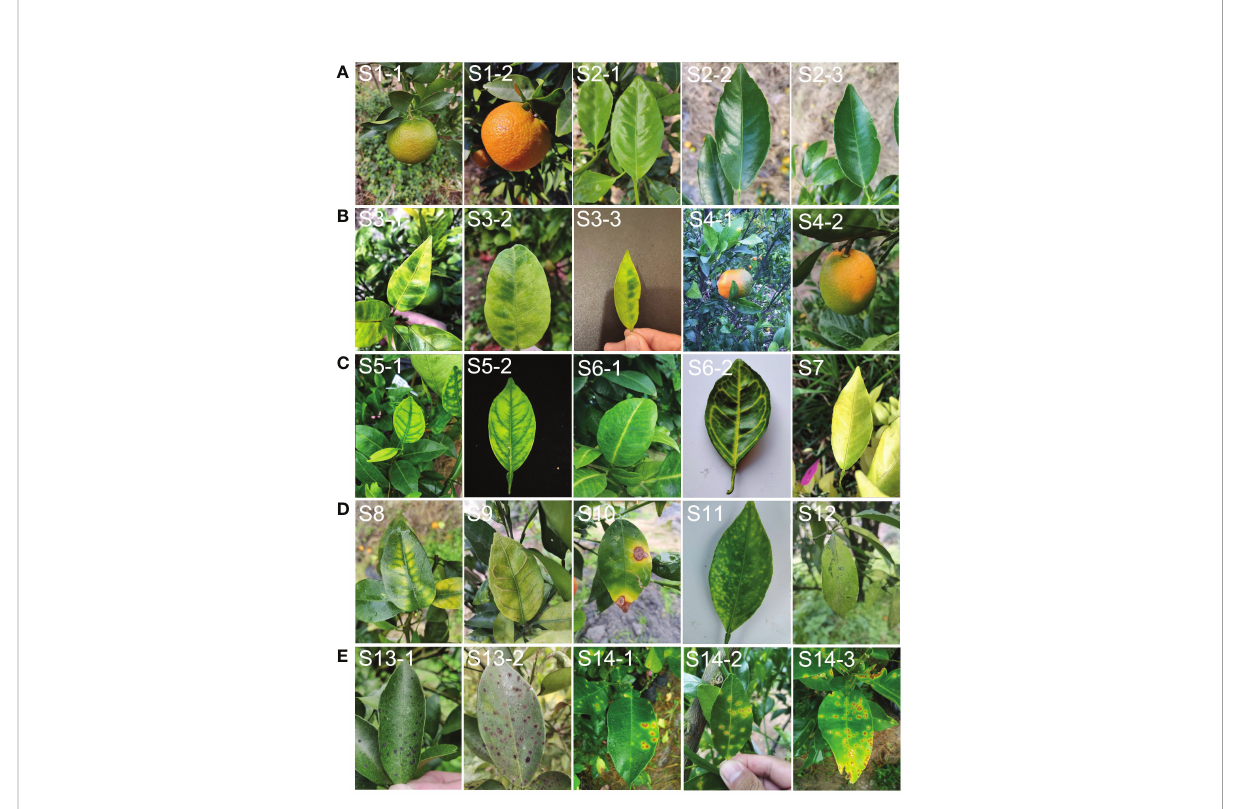
FIGURE 2 Example of leaf and fruit images with different symptoms used in the study. (A) , representative images classi fi ed as dataset ‘ A ’ (healthy). (B) , representative images classi fi ed as dataset ‘ B ’ (typical HLB symptoms). (C) , representative images classi fi ed as dataset ‘ C ’ (suspected HLB symptoms). (D) , representative images classi fi ed as dataset ‘ D ’ (HLB-like symptoms). (E) , representative images classi fi ed as dataset ‘ E ’ (HLB- irrelevant symptoms). S1, healthy fruit; S2, healthy leaf; S3, blotchy mottling; S4, “ red-nose ” fruit; S5, zinc-de fi ciency; S6, vein-yellowing; S7, uniform yellowing; S8, magnesium-de fi ciency; S9, boron-de fi ciency; S10, anthracnose; S11, citrus greasy spot; S12, citrus moss; S13, Sooty mould; S14,